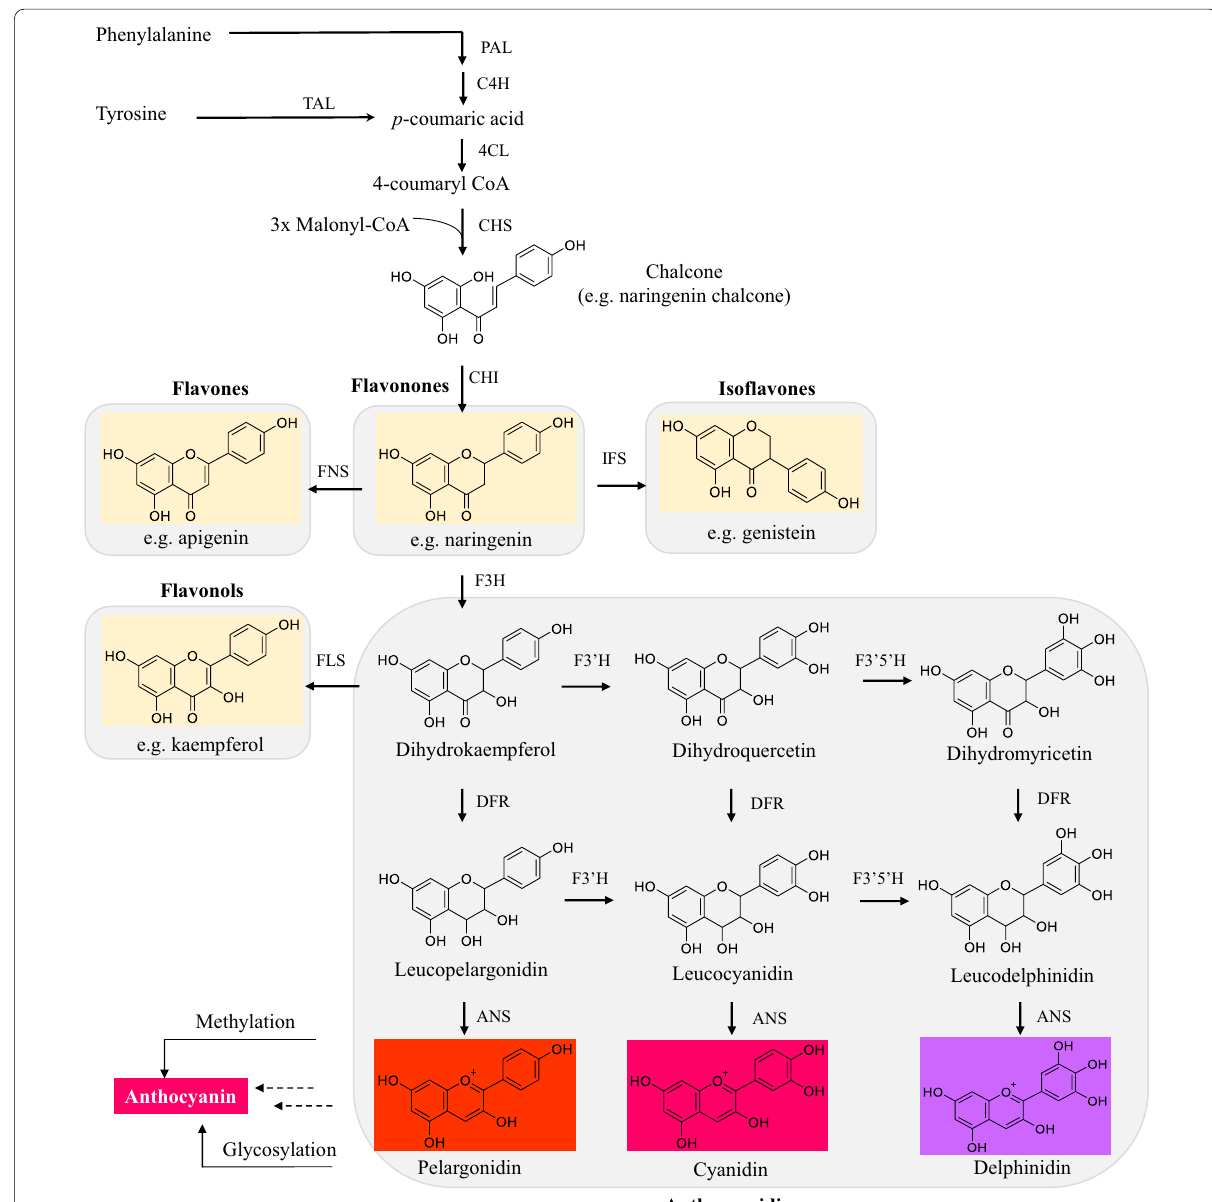
Fig. 9 Schematic of flavonoids biosynthesis. PAL, phenylalanine ammonia lyase; C4H, cinnamate 4-hydroxylase; 4CL, p-coumaric acid: CoA ligase; TAL, tyrosine ammonia lyase; CHS, chalcone synthase; CHI, chalcone isomerase; FNS, flavone synthase; IFS, isoflavone synthase; F3H, flavanone 3-hydroxylase; FLS, flavonol synthase; F3 ′ H, flavonoid 3 ′ -hyroxylase; F3 ′ 5 ′ H, flavonoid 3 ′ ,5 ′ -hyroxylase; DFR, dihydroflavonol reductase; ANS, anthocyanidin